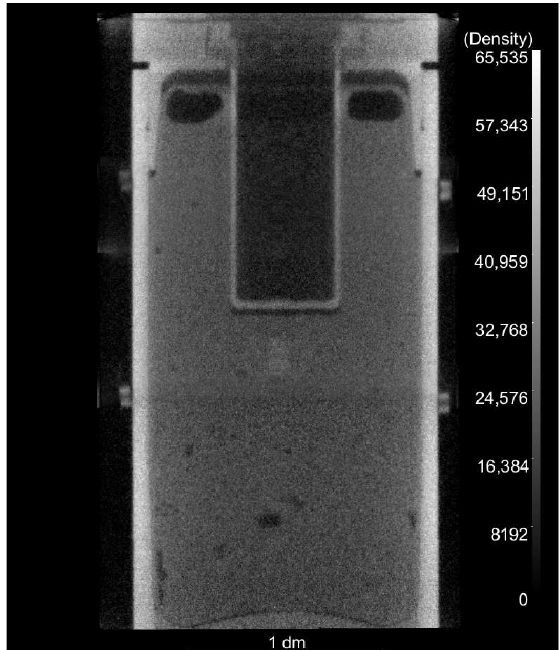
Figure 1. Full side profile of the reconstructed simulated munition, reassembled from 3 separate neutron radiography computed tomography experiments on overlapping segments of the